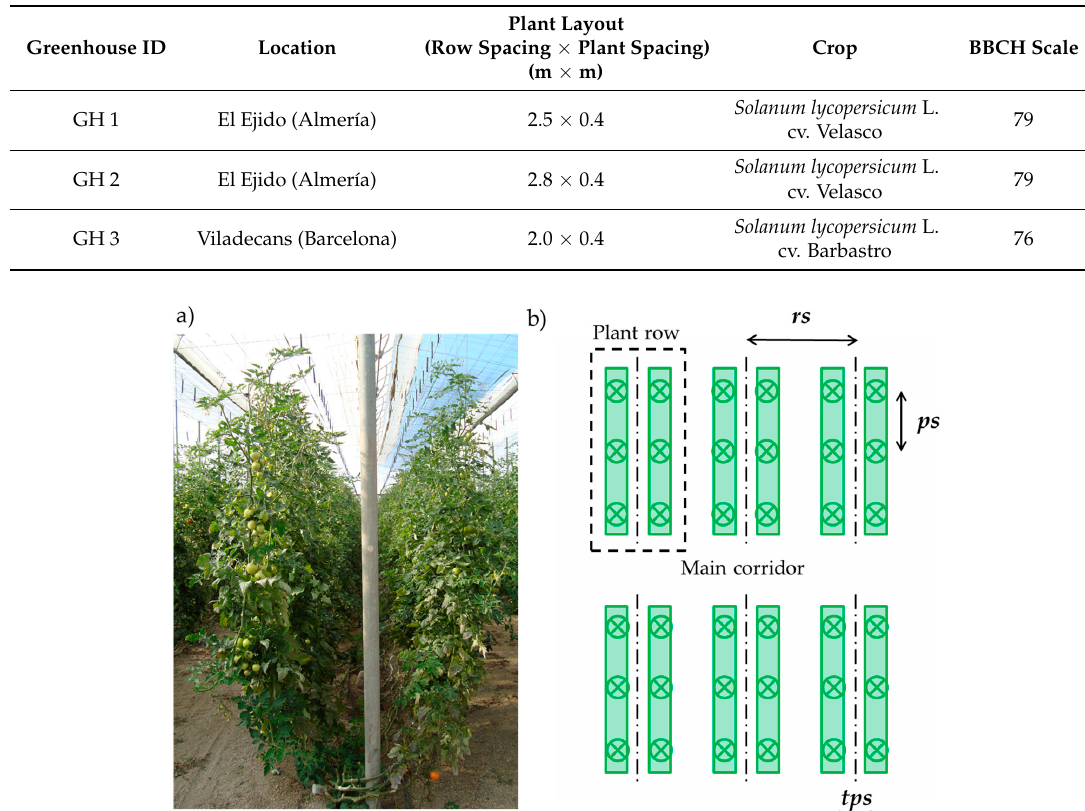
Figure 1. ( a ) Twin plantation system; ( b ) Plantation layout inside the greenhouse, with row spacing, rs , plant spacing in a row, ps , and twin plant spacing, tps .